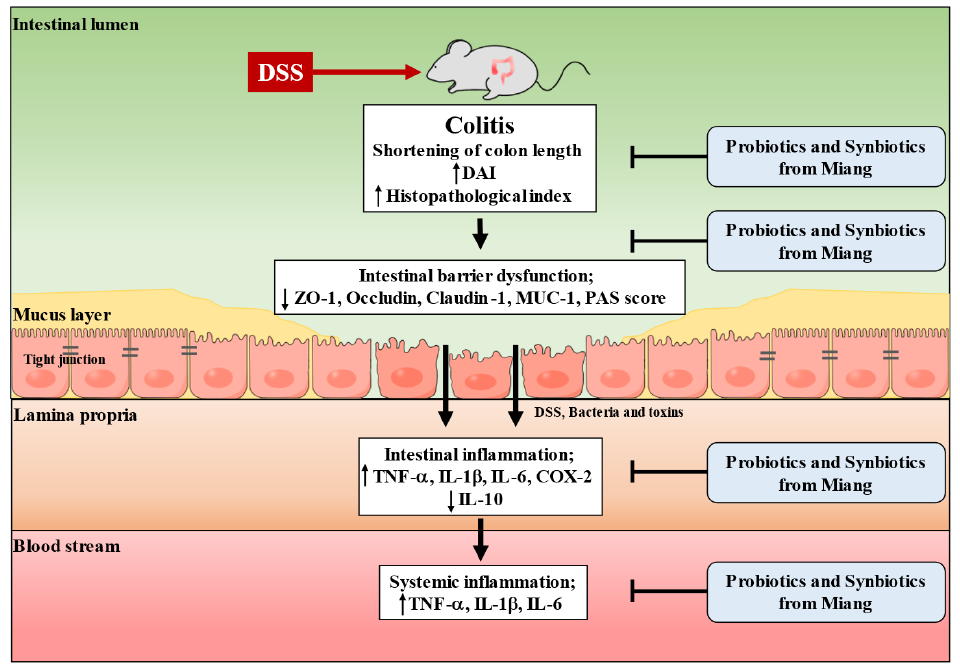
Figure 8. The proposed model represents the protective effect of probiotics and synbiotics on ameliorating intestinal inflammation induced by DSS in mice. DSS, dextran sulfate sodium; DAI, disease activity index; ZO-1, zonula occludin-1; MUC-1, mucin 1; PAS, periodic acid Schiff; TNF- α, tumor necrosis factor- α; IL - 1β, interleukin 1β; IL -6, interleukin 6; IL-10, interleukin 10; COX-2, cyclooxygenase 2.